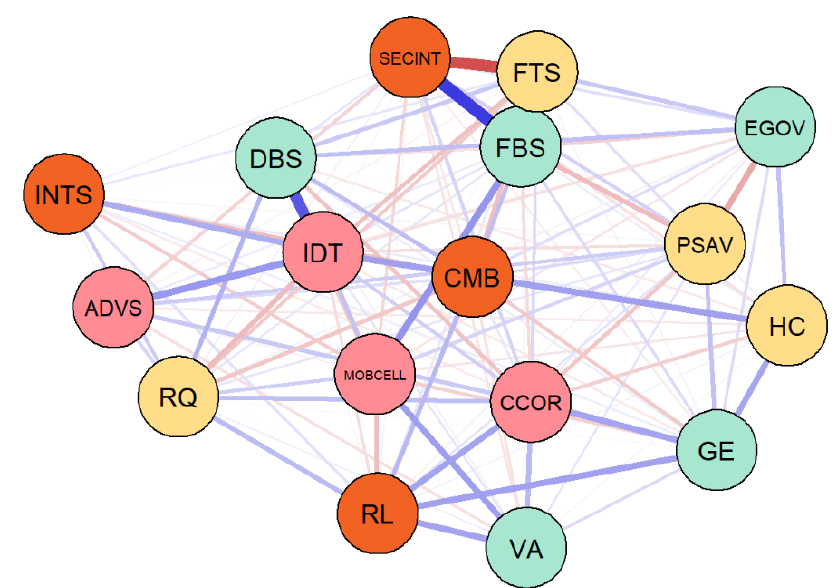
Figure 6. Results of the Mixed-Markov graphical model (MGM). Source: Authors’ research in RStudio 4.2.2.